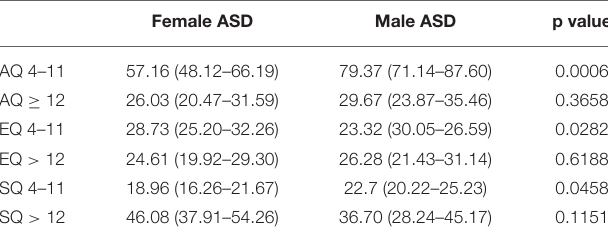
TABLE 4 | Autism quotient, empathy quotient, systematizing quotient. Female ASD Male